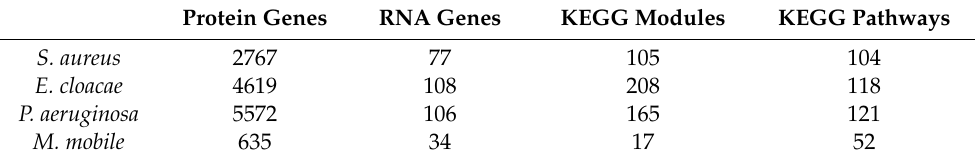
Table 1. Number of genes, modules, and pathways for the reference strains in the KEGG database. Protein Genes RNA Genes KEGG Modules KEGG